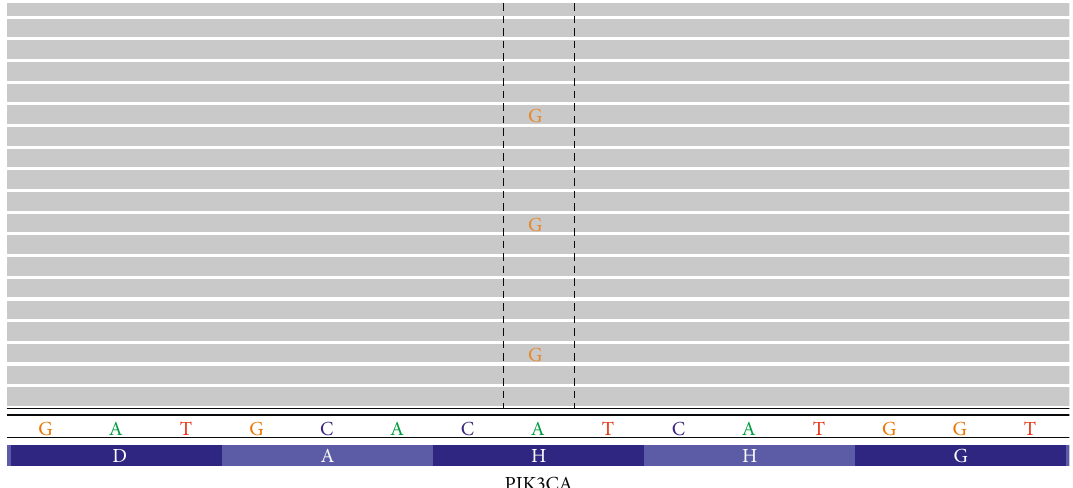
Figure 3: Next generation sequencing results demonstrate a low allele frequency c.3140A > G (p.His1047Arg) mutation of the PIK3CA gene. Reference amino acids and coding nucleotides are indicated at the bottom. Gray bars represent wild-type